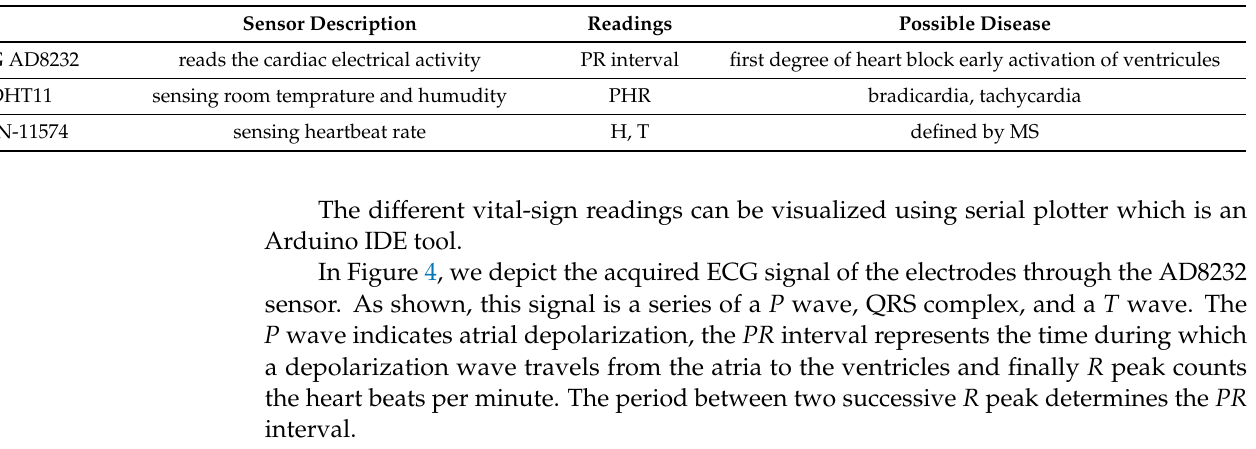
Figure 3. Developed system for LoRaChainCare. Table 2. Description of healthcare sensors connected to Arduino Uno.